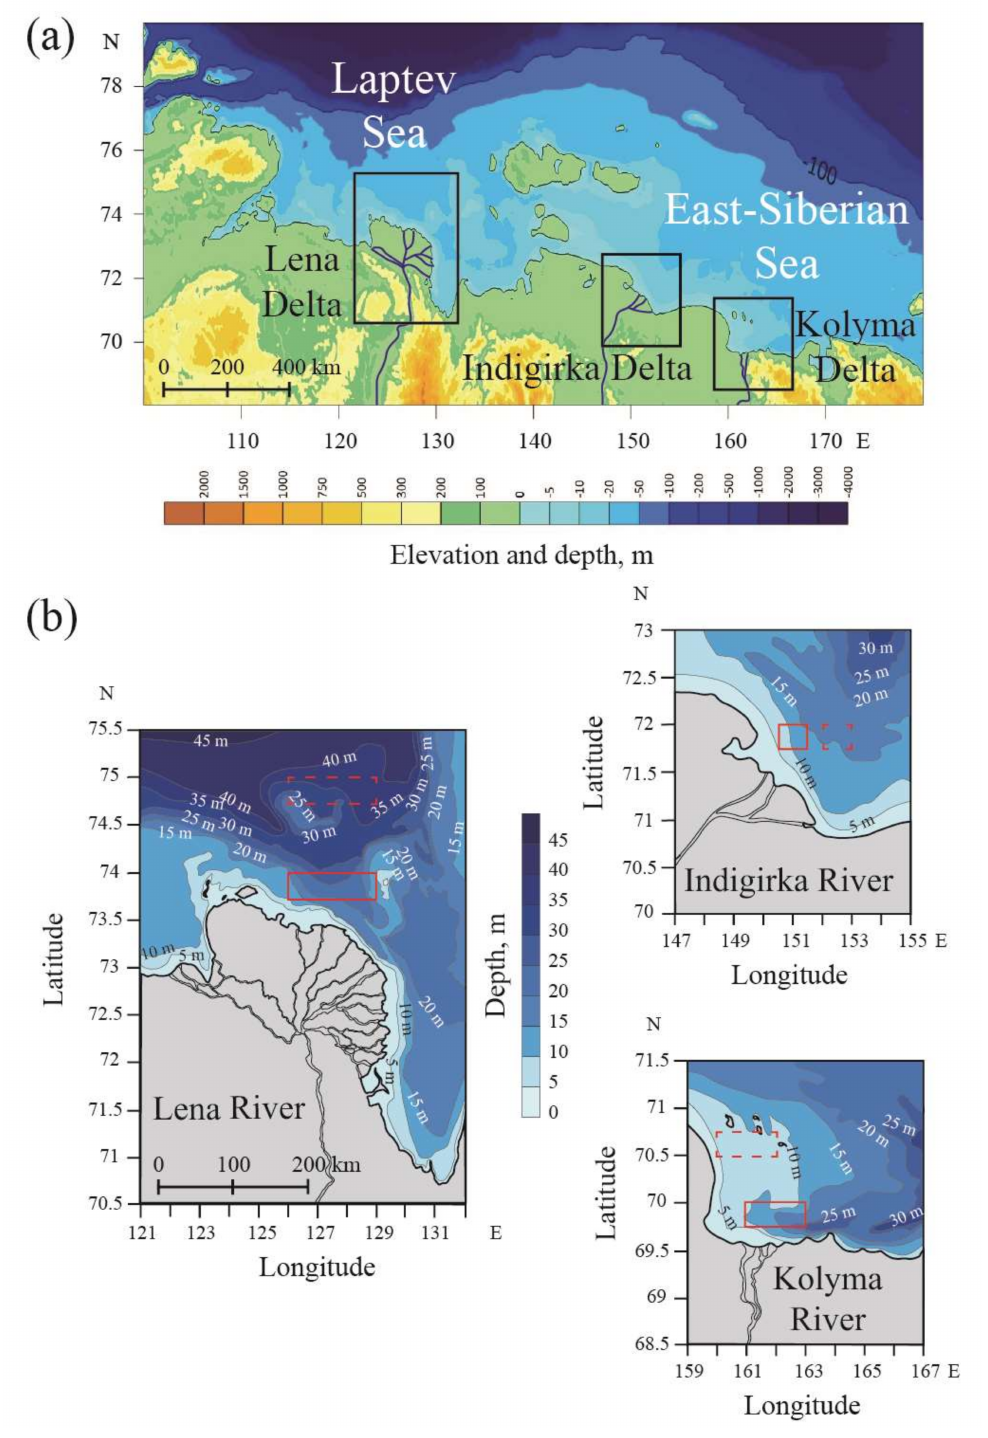
Figure 1. ( a ) Bathymetry and topography of the study region locations of the Lena, Indigirka, and Kolyma deltas in the Laptev and East-Siberian seas; ( b ) bathymetry of the areas adjacent to the Lena, Indigirka, and Kolyma deltas. The graphic scales correspond to the latitude of 72 ◦ . Red boxes indicated in panel ( b ) show locations of reference areas in the upwelling regions (dashed contours) and the ambient sea (solid contours) used to identify upwelling